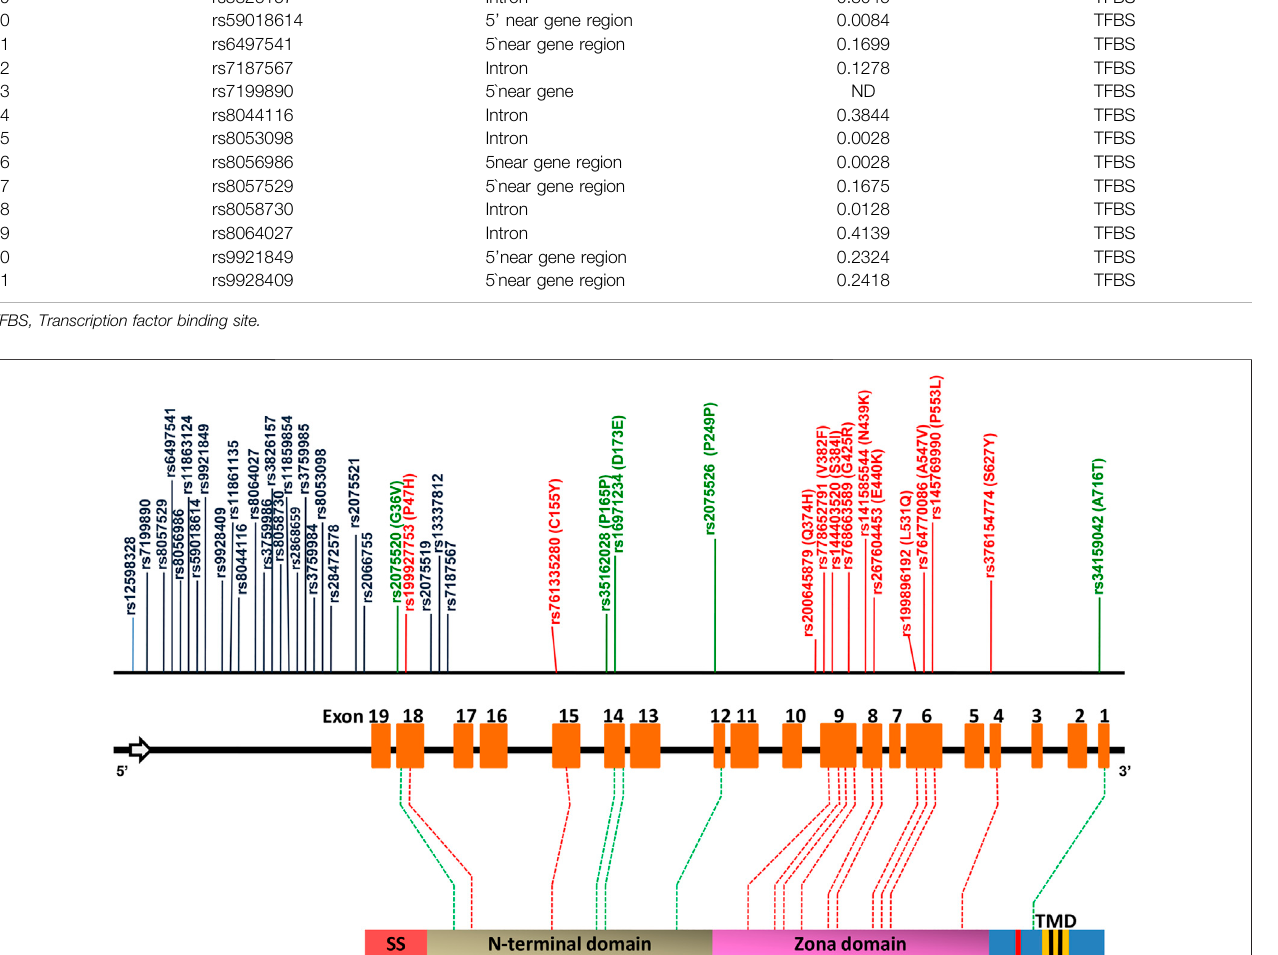
Frontiers in Cell and Developmental Biology |